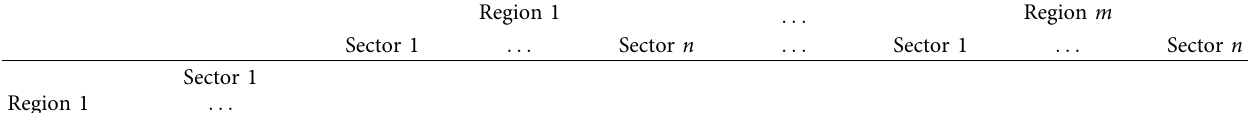
Table 1: Inter-regional industrial technology correlation (IRITC) matrix ( mn × mn